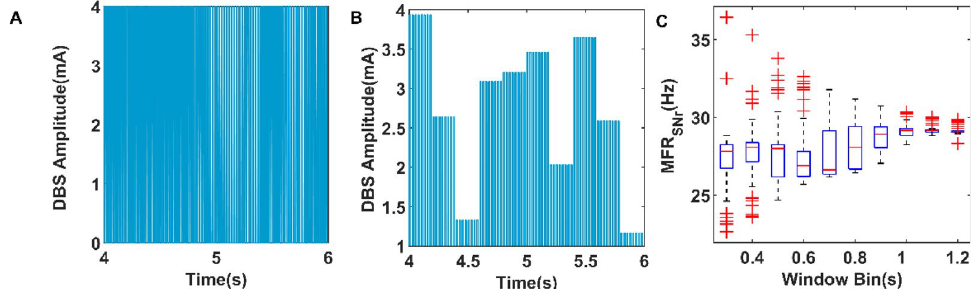
Figure 3. ( A ) The DBS current with different frequency. The duration of each current is 0.2 s, and the current frequency is between 20 and 100 Hz. ( B ) The DBS current with different amplitude. The duration of each current is 0.2 s, and the current amplitude is between 1 and 4 mA. ( C ) The box figure of mean firing rate of SNr plotted as a function of time window bin (60 trials), where the blue rectangle consists of the median, upper quartile and lower quartile, and the outliers are marked with red crosses. MFR SNr represents mean firing rate of SNr.